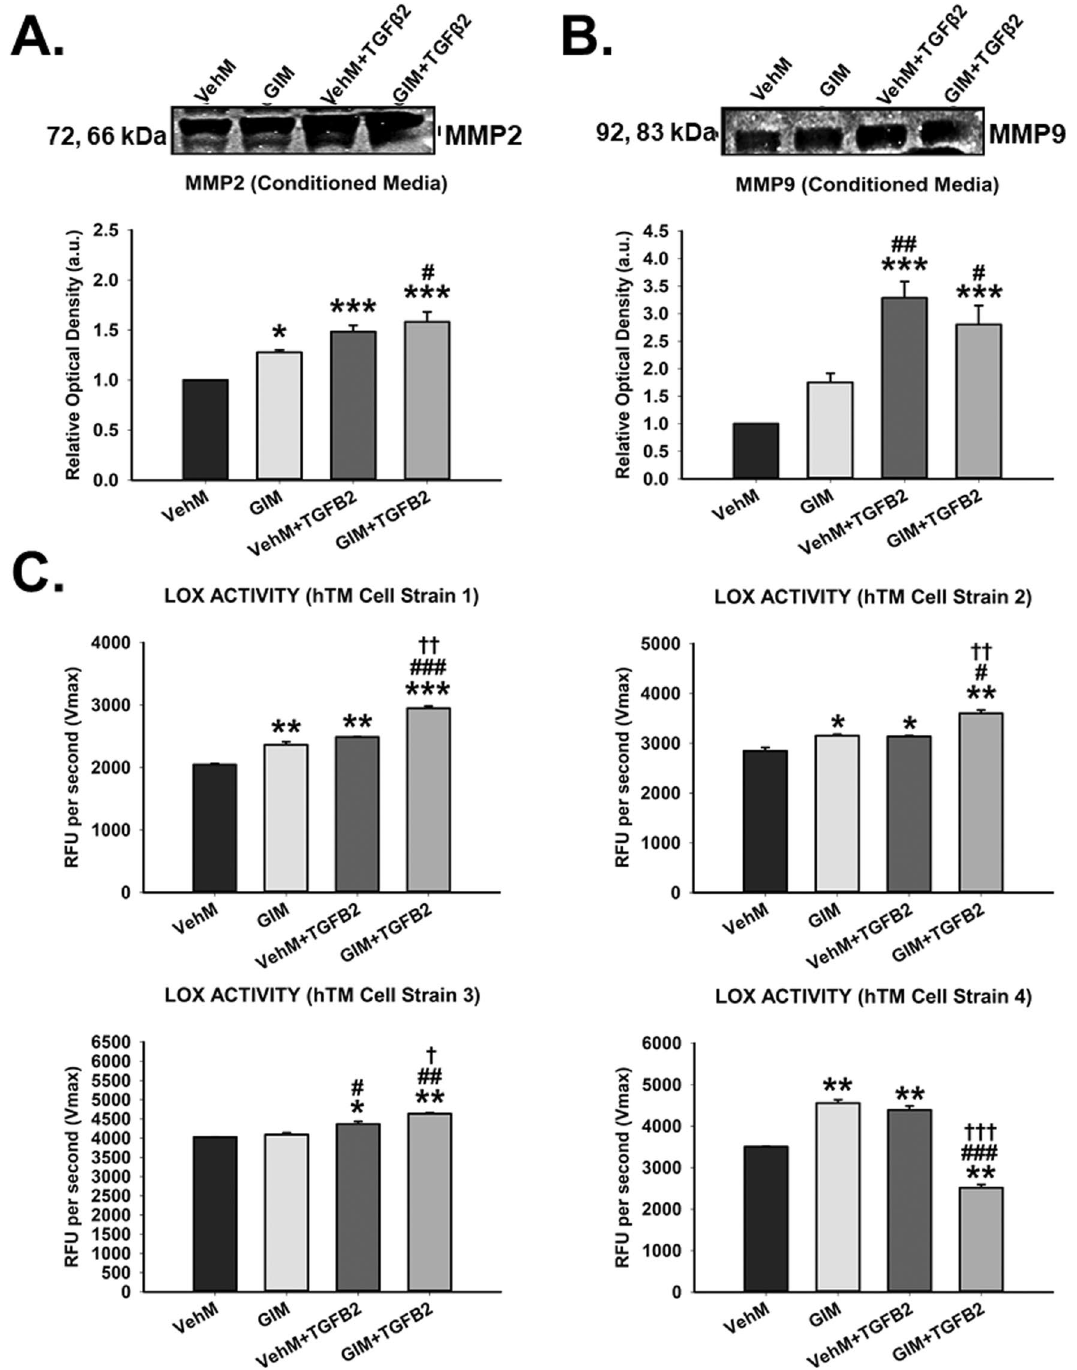
Figure 8. GIMs increase activities of MMP2 and MMP9 together with LOX in the presence or absence of TGFβ2 in conditioned media. Conditioned medium from primary hTM cells cultured on vehicle control (VehMs) or GIM substrates for 7 days were collected and normalized to total protein concentration prior to determining enzyme activity in each sample. Gelatin Zymography was used to determine enzyme activity of specific MMPs in the absence or presence of TGFβ2. Representative cropped gel bands of ( A ) MMP2 and ( B ) MMP9 enzymatic activity. Full length gel zymograms are shown in Supplementary Fig. S9. ( C ) Lysyl oxidase enzyme activity was determined as the Vmax (in RFU units per second) for four different cell strains. Columns and error bars ; means and standard error of mean (SEM). One-way ANOVA with the Tukey pairwise comparisons post hoc test was used for statistical analysis. (n = 4 biological replicates. *p < 0.05, **p < 0.01, ***p < 0.001 for the group of interest versus control, VehM. #p < 0.05, ##p < 0.01, ###p < 0.001 for the group of interest versus GIM. † p < 0.05, †† p < 0.01, ††† p < 0.001 for VehM + TGFβ2 versus GIM + TGFβ2). hTM, human trabecular meshwork. Densitometric analyses of the zymographs was done using ImageJ 1.8.0_112 software (https ://image j.nih.gov/ij/, 1997–2018). Enzyme activity was measured using the SoftMax Pro 7 Data Acquisition and Analysis Software (Molecular Devices; https ://www.molec ulard evice s.com/produ cts/micro plate -reade rs/acqui sitio n-and-analy sis-softw are/softm ax-pro-softw